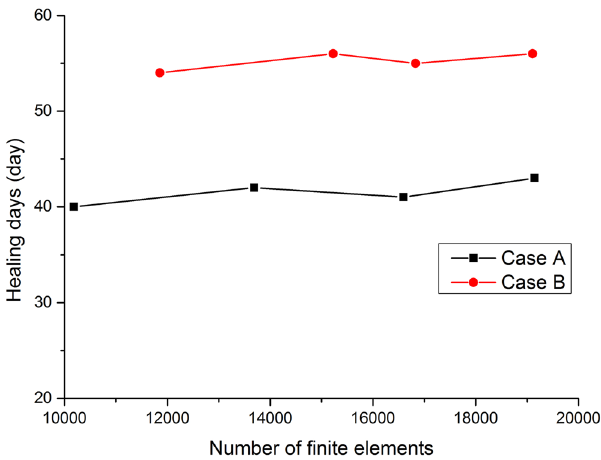
Figure 9. Mesh convergence analysis for case A and case B. Influence of number of finite elements on predicted healing days for both cases A and